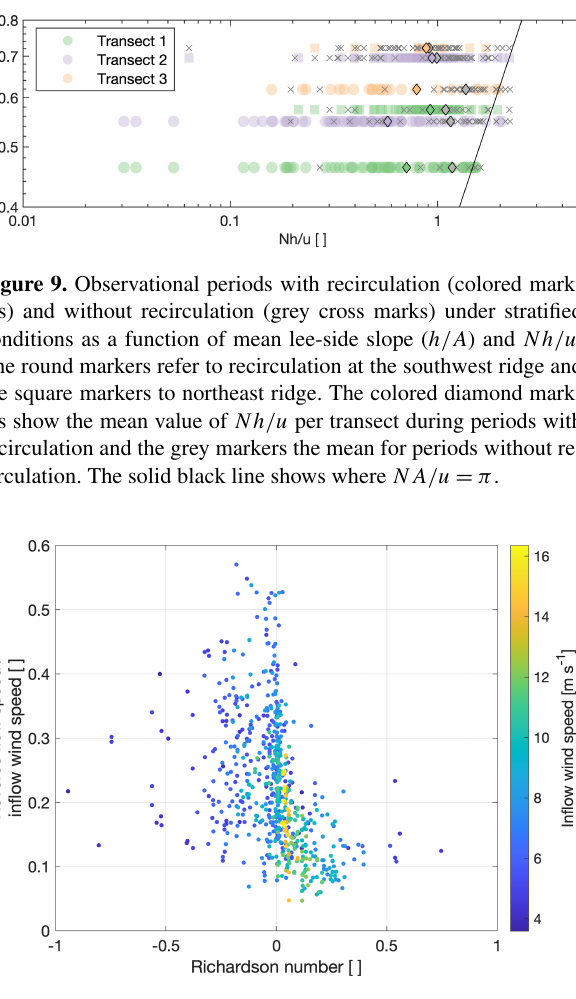
Figure 10. Maximum reverse flow speed divided by the inflow wind speed over the Richardson number. The color scaling shows the wind speed measured at the upstream mast 100m above ground.